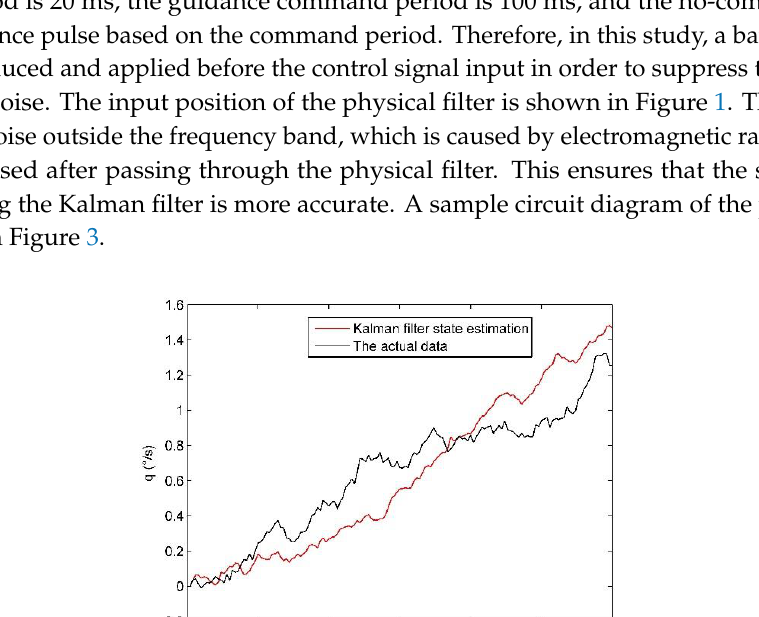
Figure 2. Kalman filter state estimation under the interference of approximate control signal noise.